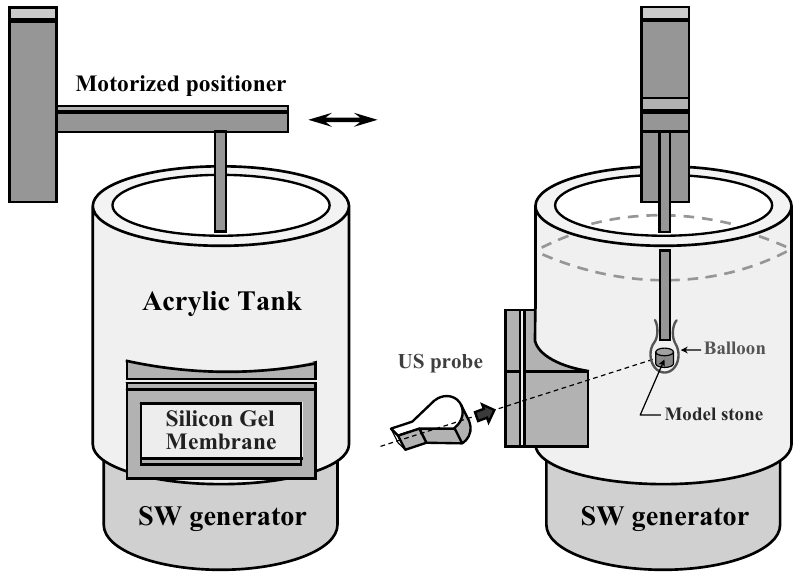
Figure 8. The front (left) and side (right) views of the devices for the in vitro automatic stone tracking